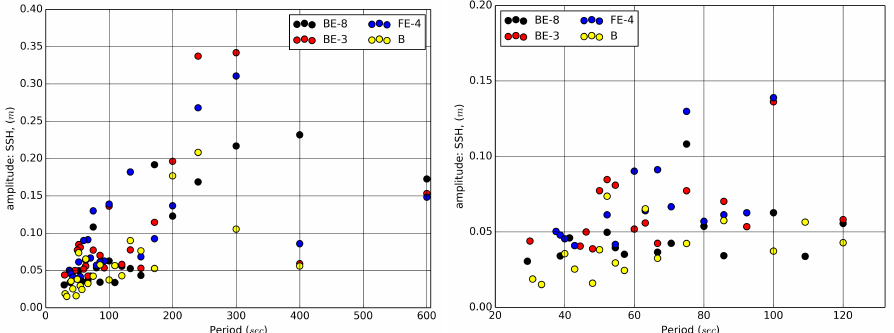
Figure 11. The first 20 maximum amplitudes of the frequency spectrum of 4 experiments. Left panel—entire period range; right panel—period range from 20 to 120